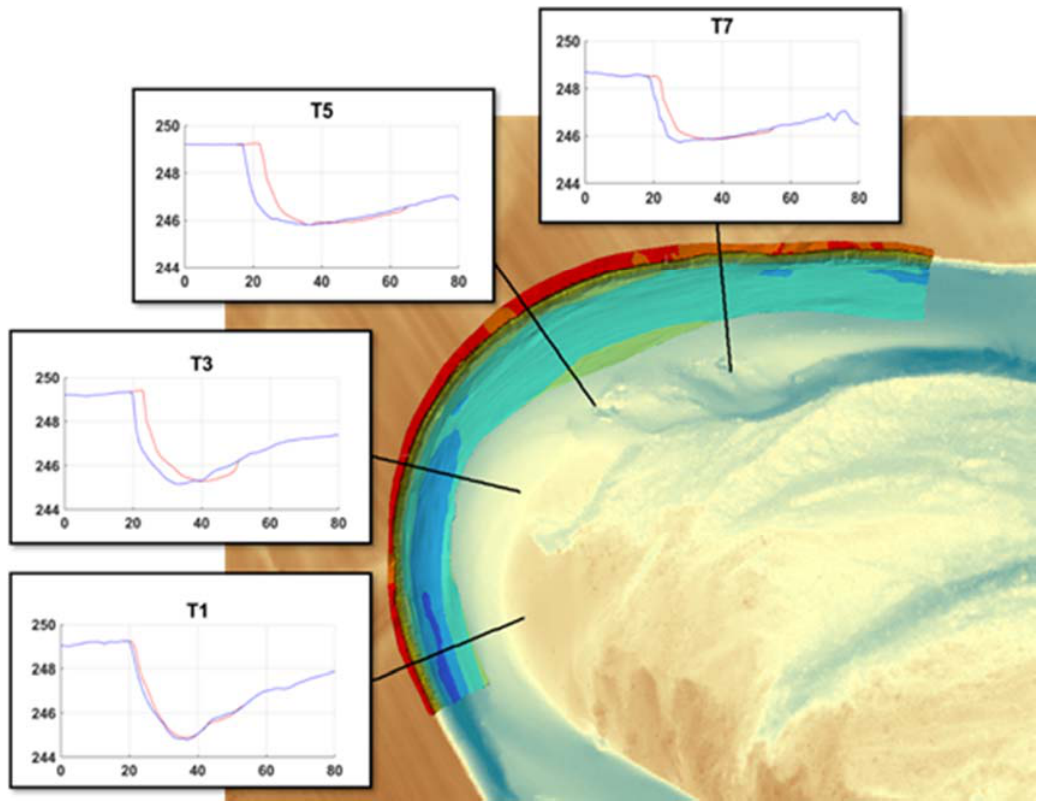
Figure 9: Extracted cross-sections of pre-flood TIN model and post-flood LiDAR DEM of the meander